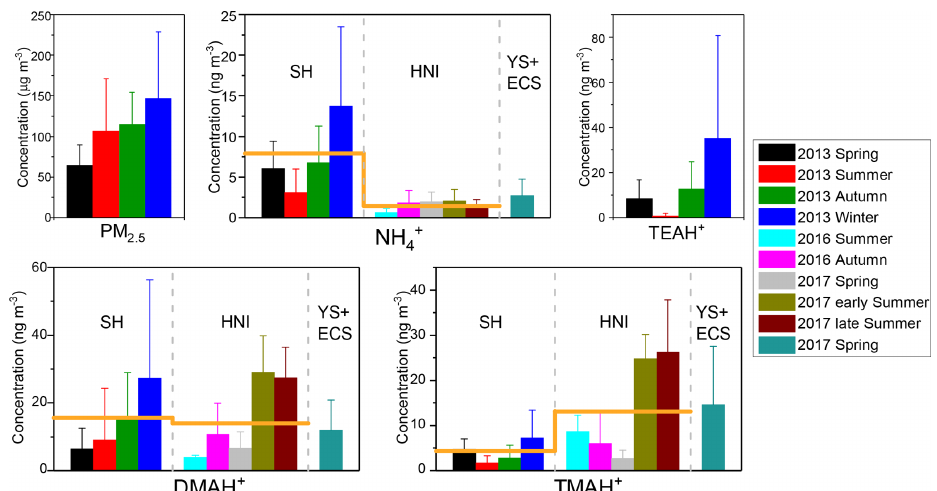
Figure 2. The mass concentrations of PM 2 . 5 , fine-particle NH + , and three aminiums (TEAH + , DMAH + and TMDEAH + ) in different 4 campaigns in Shanghai (SH), Huaniao Island (HNI) and the Yellow and East China seas (YECS). The columns and error bars represent average concentrations and standard deviations, respectively. The orange horizontal lines represent the annual average concentrations of aminiums in SH and HNI.